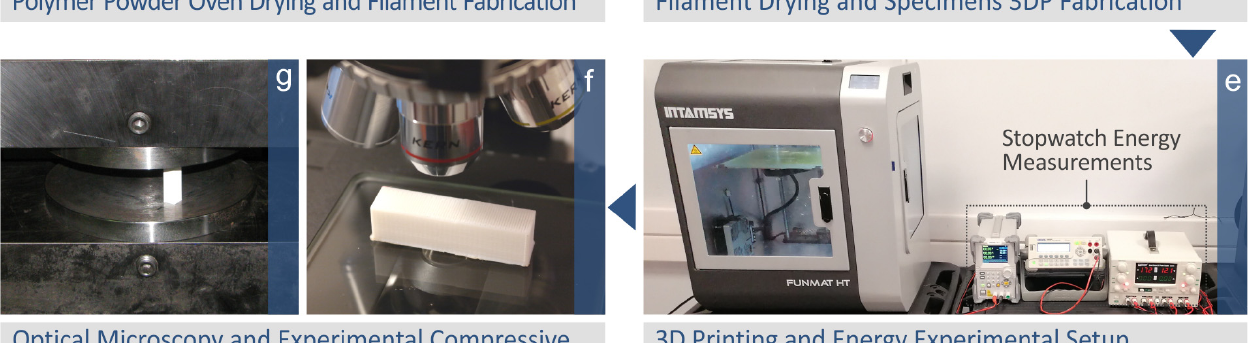
Figure 3. Graphic representation of the 3D printing process, defining the 3D printing parameters studied in this work. On the right side of the figure, the 3D printing parameter values and the ge- ometry of the compression test sample fabricated following the ASTM D695 standard are presented. 2.2. Energy Indicators Regarding energy consumption, it can be distinguished into three main phases: (i) machine startup, (ii) 3D printing process, and (iii) machine shutdown and can be cal- culated utilizing the equations below [17]: E (cid:2930)(cid:2925)(cid:2930)(cid:2911)(cid:2922) = E (cid:2930)(cid:2918)(cid:2915)(cid:2928)(cid:2923)(cid:2911)(cid:2922) + E (cid:2923)(cid:2925)(cid:2930)(cid:2919)(cid:2925)(cid:2924) + E (cid:2911)(cid:2931)(cid:2934)(cid:2919)(cid:2922)(cid:2919)(cid:2911)(cid:2928)(cid:2935) (1) where,